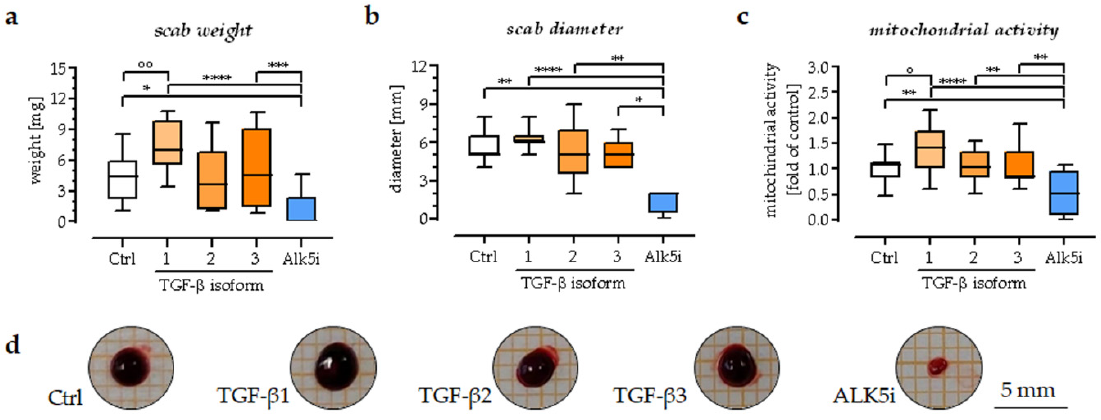
Figure 6. Effect of exogenous stimulation with recombinant human TGF- β isoforms and their inhibitor (Alk5i) on the weight, area, and mitochondrial activity of the in vitro scabs. ( a ) Weight of the in